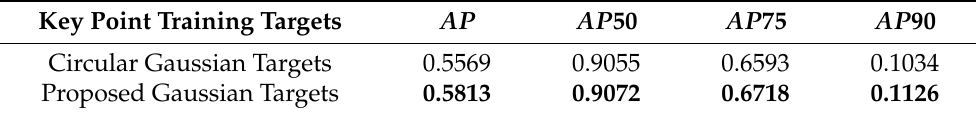
Table 3. Effectiveness of Oriented Gaussian Training